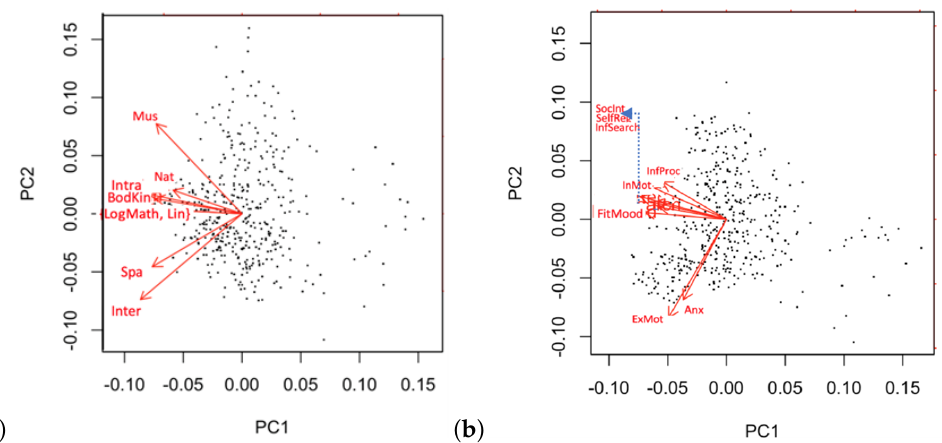
Figure 3. PCA Biplot diagrams and Correlation of dimensions of ( a ) MI and ( b ) SRLAS